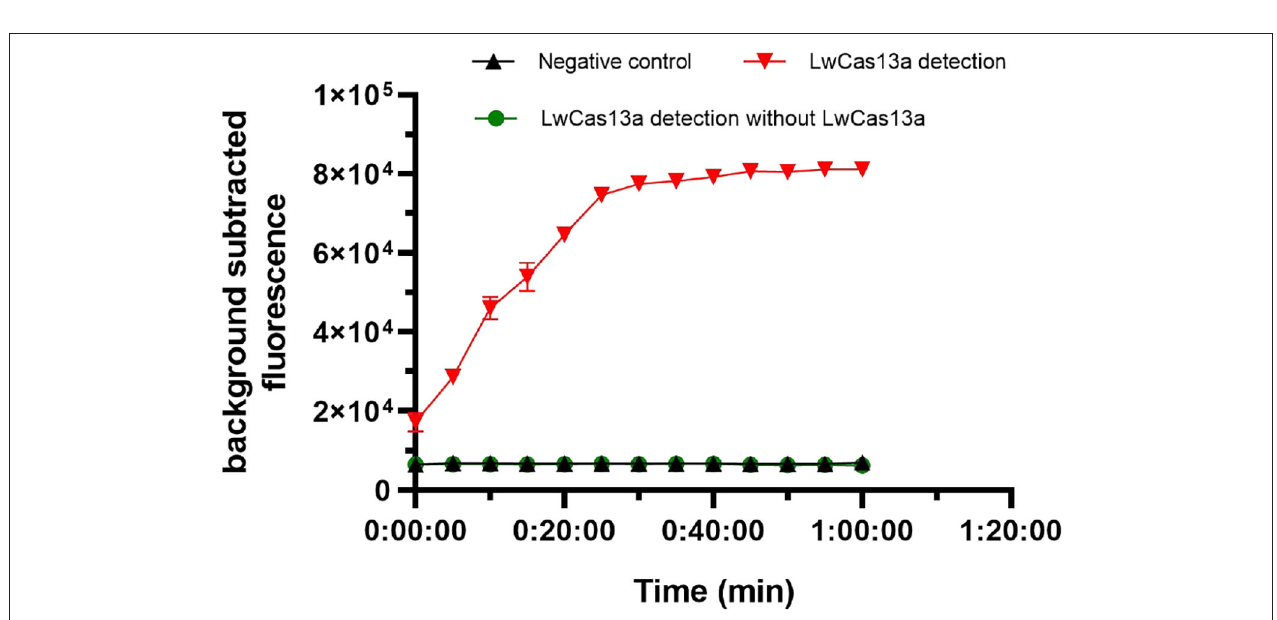
FIGURE 4 | Activity of purified LwCas13a protein ( n = 3 technical replicates; values represent mean ± SEM).